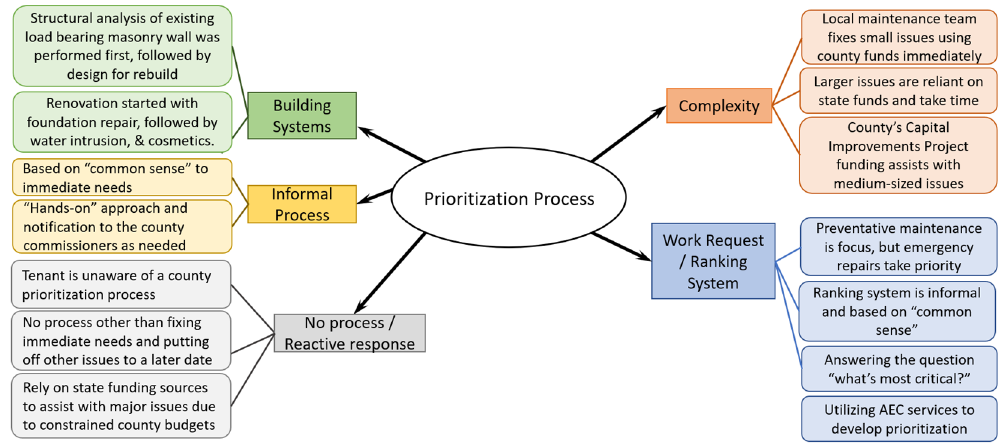
Figure 12. Results to interview question #2: organization’s prioritization process.